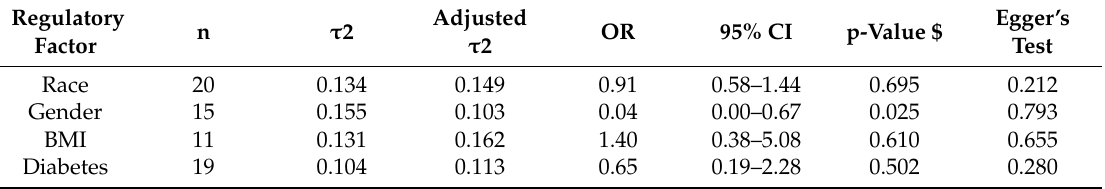
Table 5. E ff ect of regulatory factors in the meta-analysis for Pro12Ala and CKD